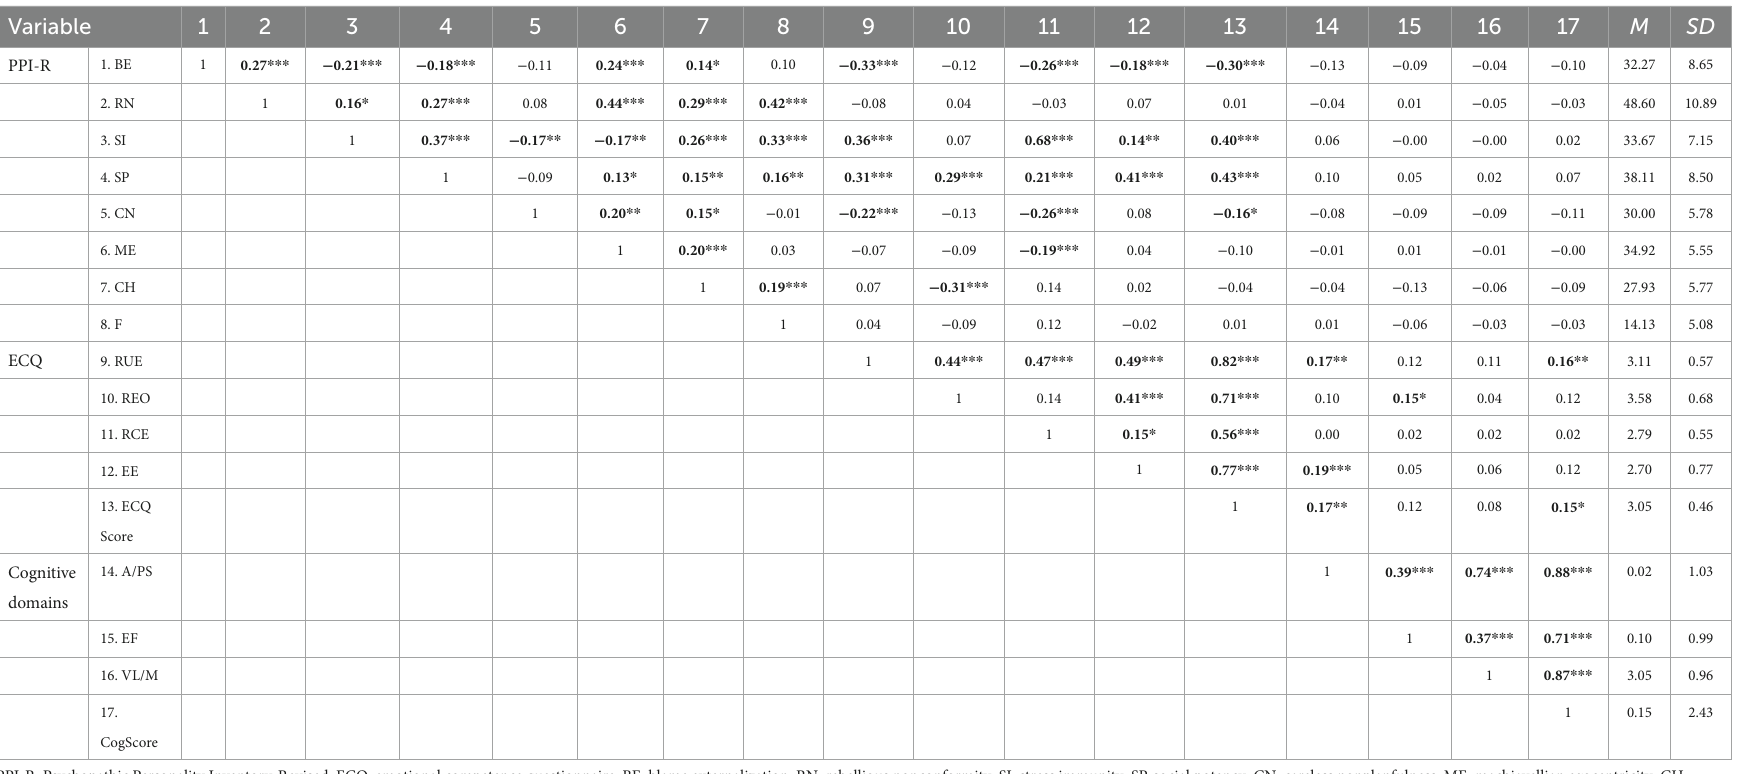
TABLE 4 Correlations, means, and standard deviations between study variables.